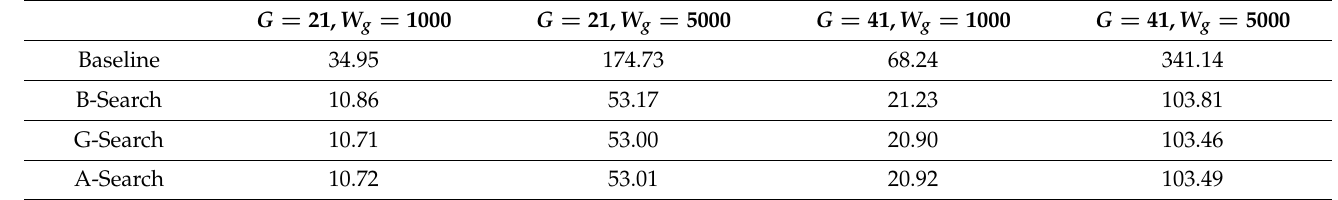
Table 1. The searching time of baseline protocol, B-Search, G-Search, and